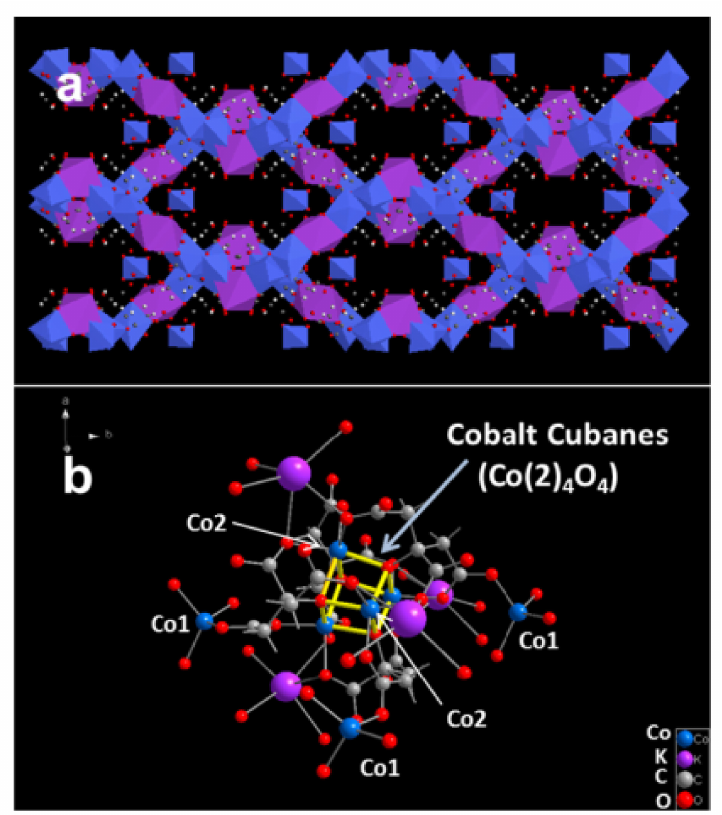
Figure 15. ( a ) Crystal structure of UTSA-16 and ( b ) representative structures of Co4O4 cubane in UTSA-16. Reproduced with permission from